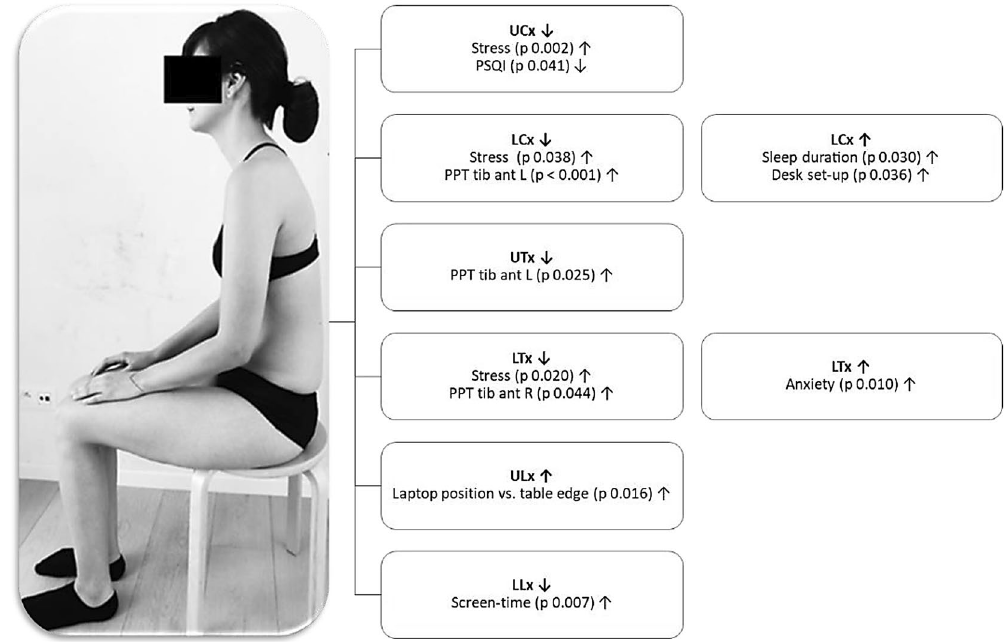
Figure 4. Summary of significant relations between BPS variables and SPV in the CeH-group (tib ant = tibialis anterior; L = Left; R = Right; PSQI = Pittsburgh Sleep Quality index; Arrows ↓ and ↑ refer to the direction of the relation, namely decrease (less movement) and increase (more movement),